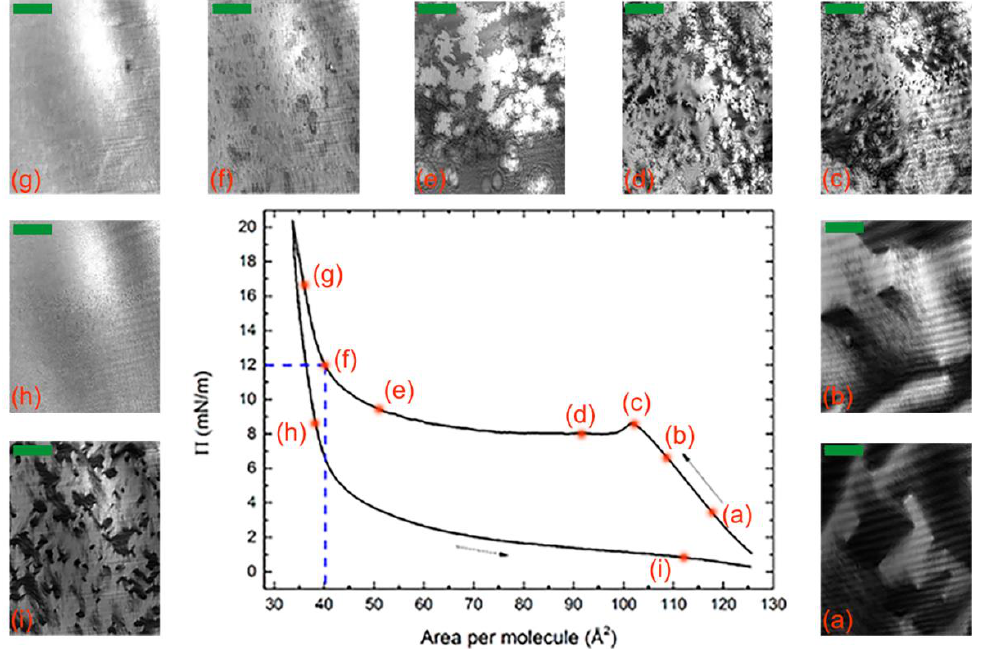
Figure 2. ( a – i ) Isotherm of a complete compression (leftward arrow) and expansion (rightward arrow) cycle and corresponding sequence of BAM images (the scale bar in each image corresponds to 100 μm). The compression/expansion rate was 70 cm 2 /min. The dashed lines indicate the deposition parameters.